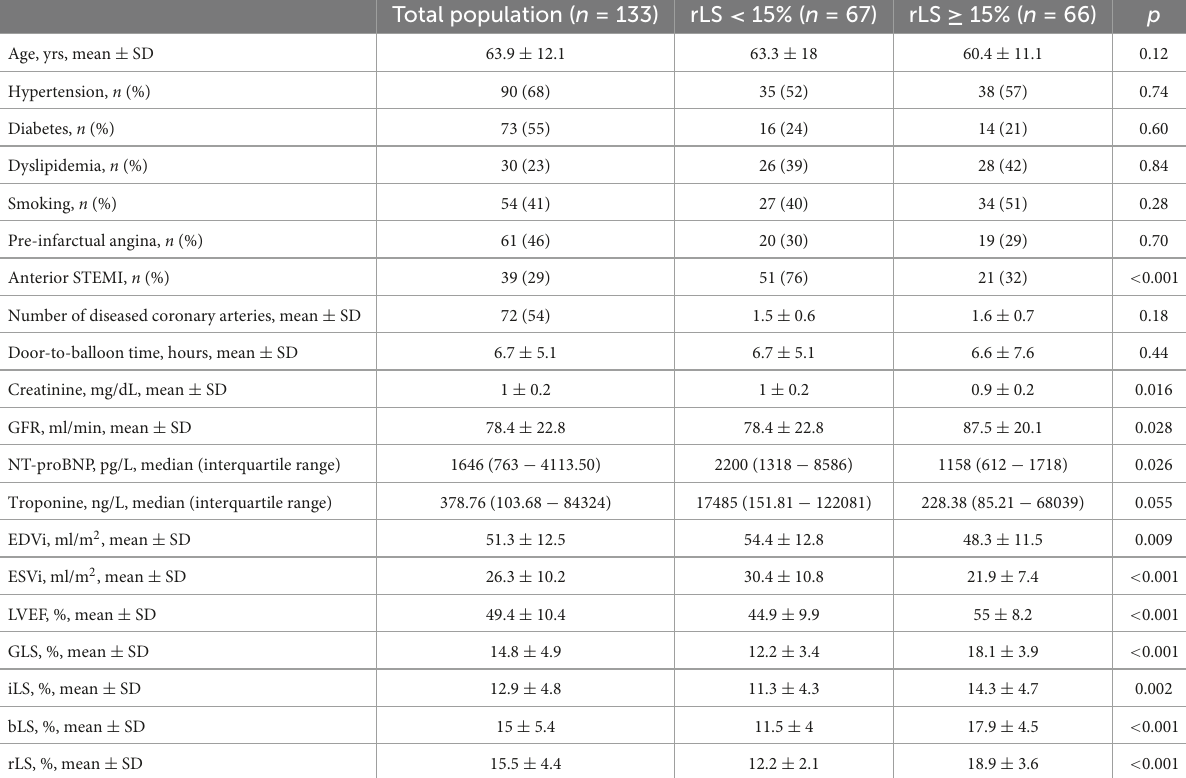
TABLE 3 Differences in baseline clinical, echocardiographic, and biological data between patients stratified by median values of rLS. Total population ( n =